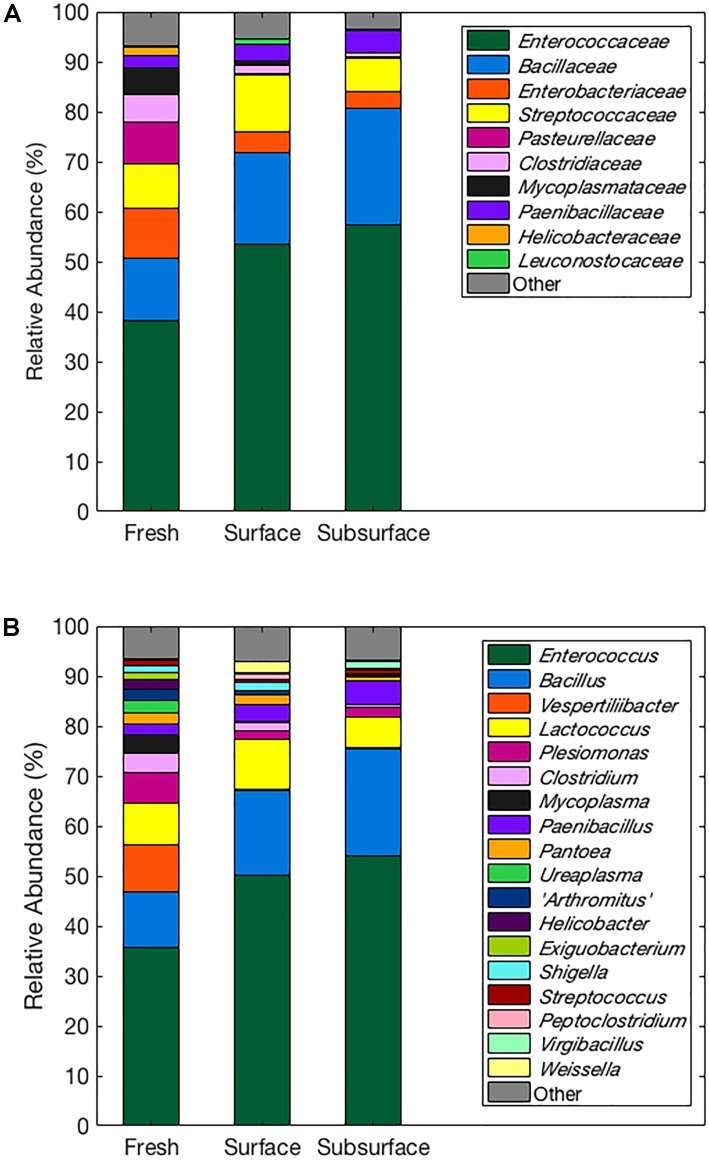
Relative abundances of bacterial taxa at the family (A) and genus (B) levels across sampling locations. All families or genera with 1% or more mean relative abundances from each sample treatment are represented by name, and families and genera with less than 1% mean relative abundances are grouped into the “other” category.